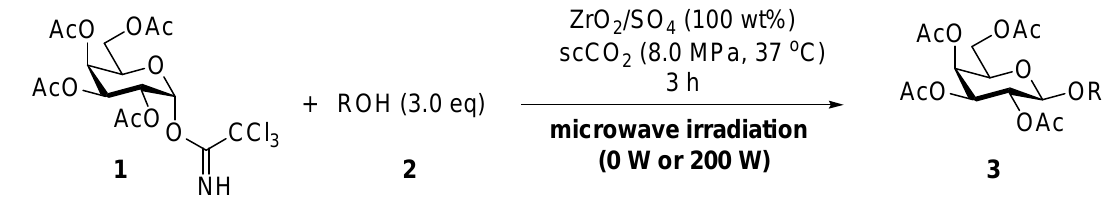
Table 1 indicates the result of the glycosylation reactions with aliphatic alcohols 2a-d . Without